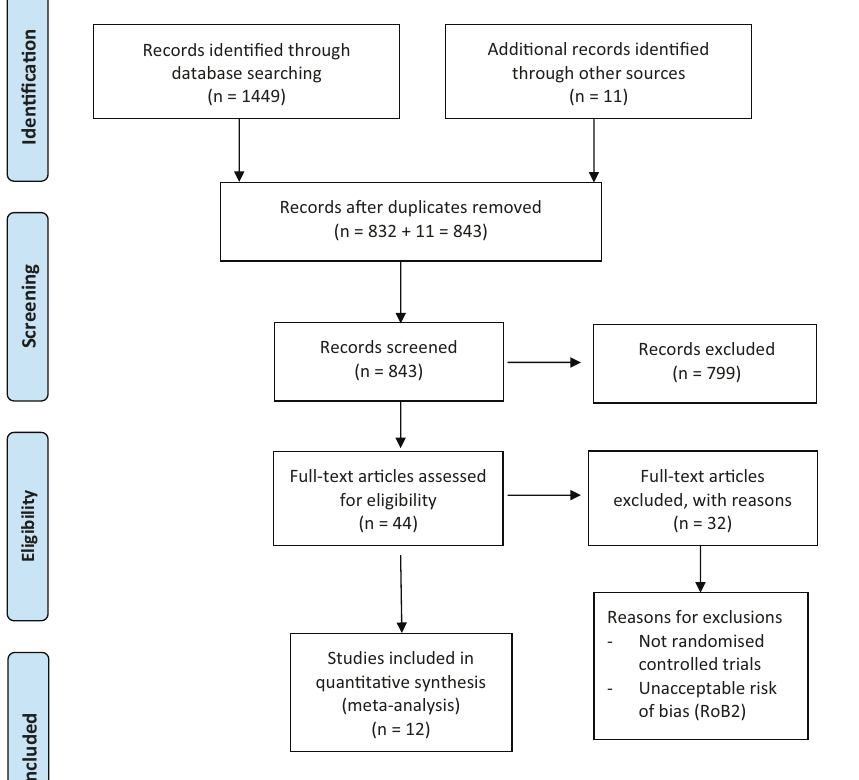
Fig. 1 PRISMA fl owchart of the search